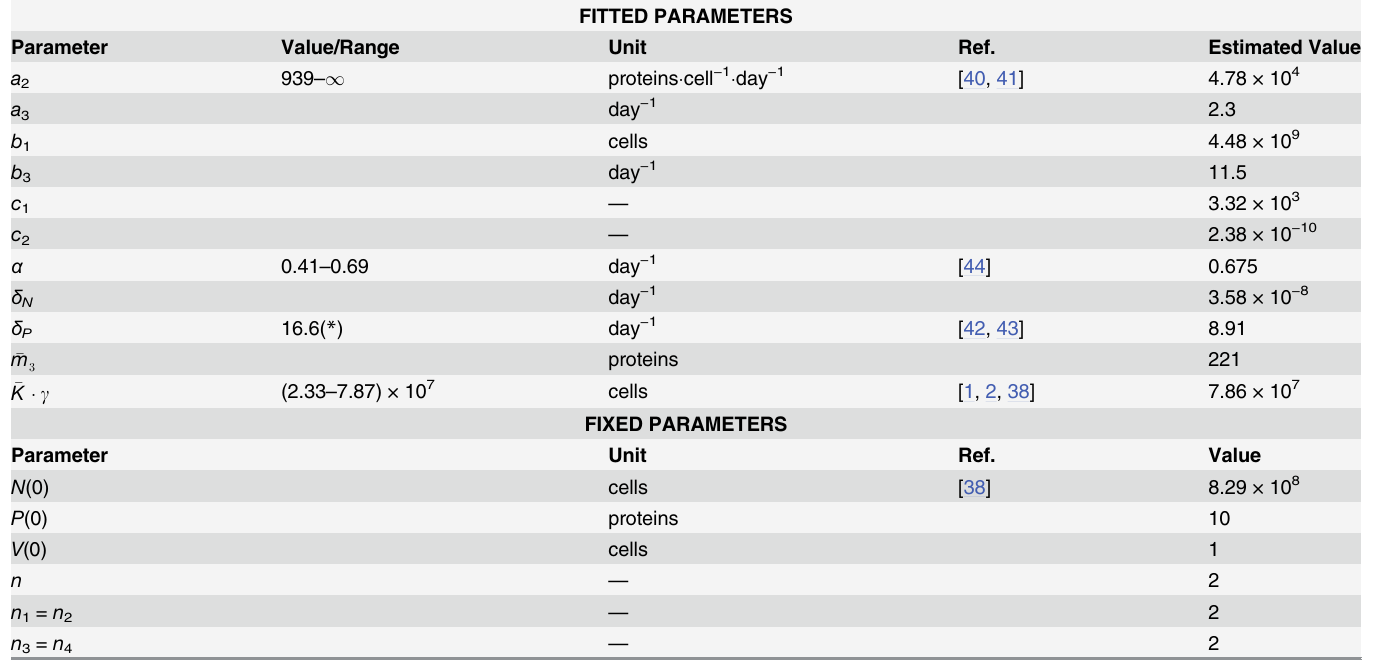
Table 3. Estimated parameters for Lewis lung